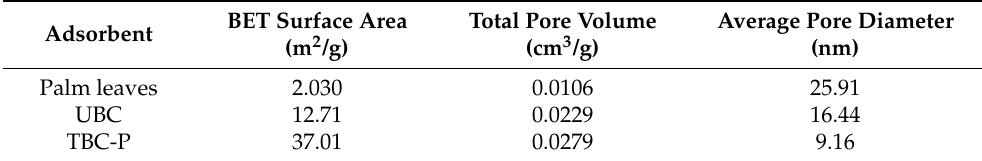
Figure 4. Hysteresis loops of palm leaves, UBC and TBC-P. Table 2. Pore characteristics of palm leaves, UBC and TBC-P.